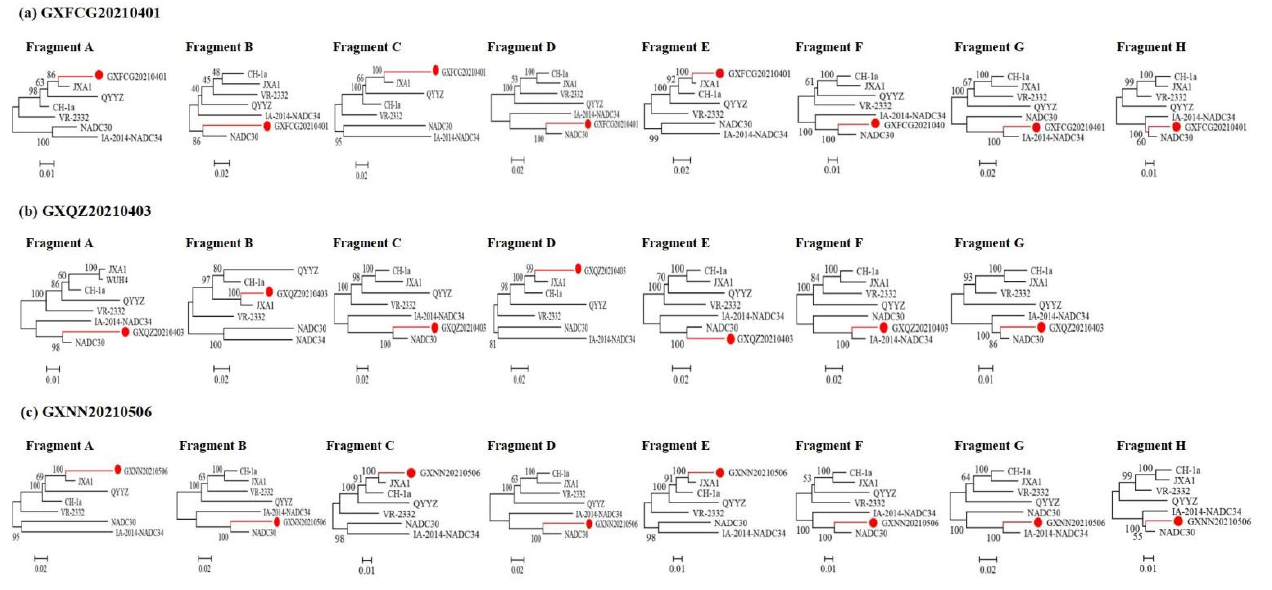
Figure 4. The isolates that were identified in the evolutionary tree are marked with red lines and red circles. The phylogenetic analysis of the different fragments of strain GXFCG20210401 is shown in ( a ). The phylogenetic analysis of the different fragments of strain GXQZ20210403 is shown in ( b ). The phylogenetic analysis of the different fragments of strain GXNN20210506 is shown in ( c ).